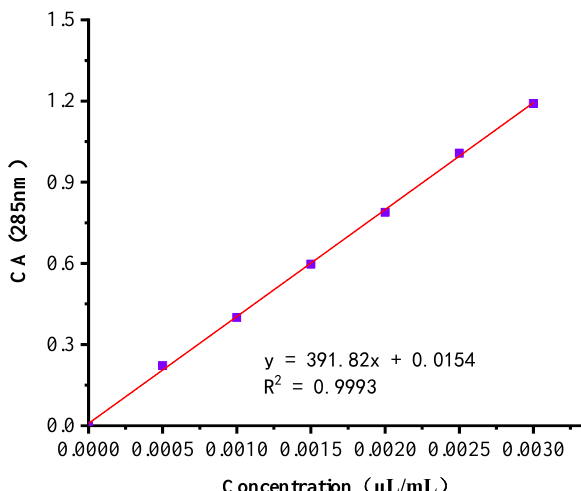
Figure 7. CA absorbance at 220 nm vs. concentration standard curve.